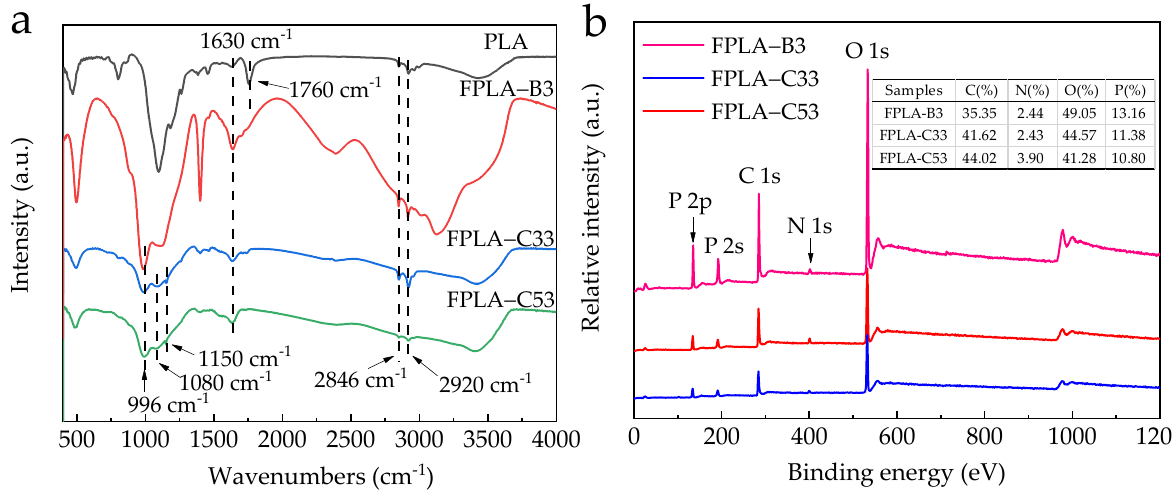
Figure 14. ( a ) FTIR curves and ( b ) XPS spectra of the residue char for PLA, FPLA-B3, FPLA-C33, and FPLA-53.